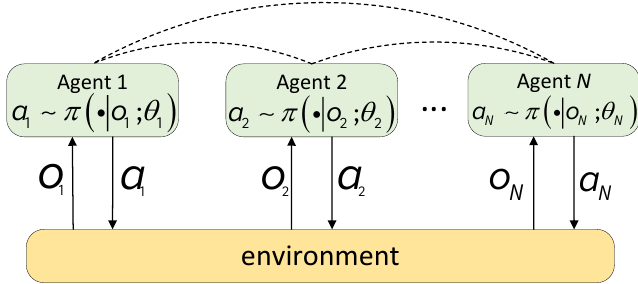
Figure 1. Schematic diagram of distributed training decentralized